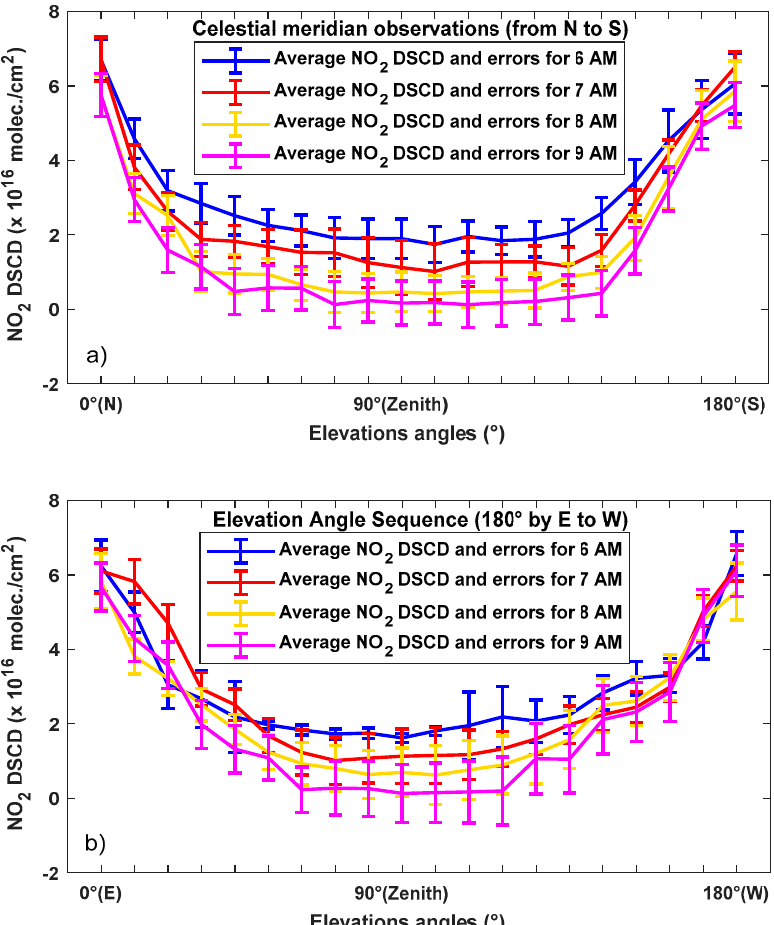
Figure 8. NO 2 DSCD and error retrieved from the VSM using the UGAL-2D-DOAS system on 21 June 2017 between 6–9 LT; ( a ) local celestial meridian; ( b ) elevation angle sequence (0–180° by E–W). Table 4 summarizes the MAX-DOAS measurements for using HSM and VSM and associated errors. Table 4. Information regarding the performed MAX-DOAS observations.